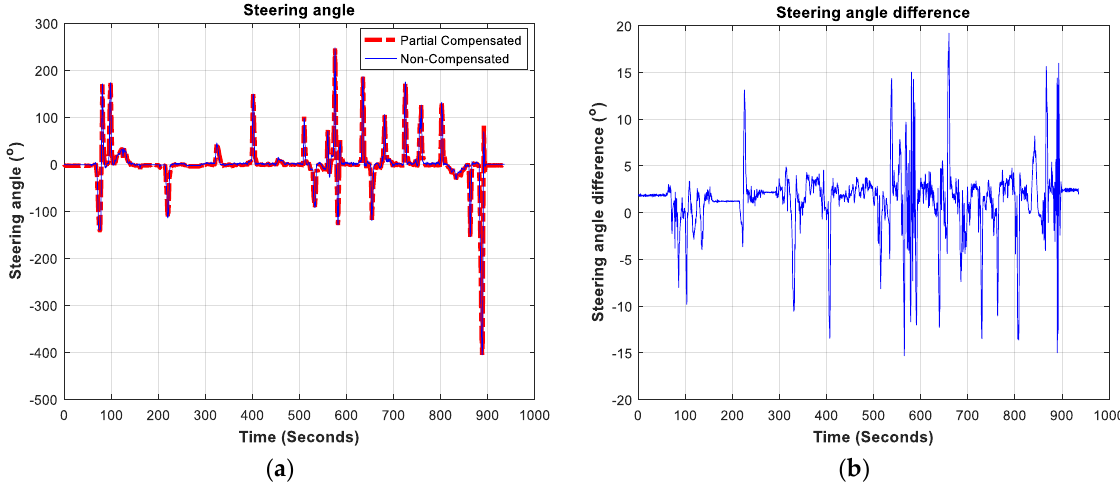
Figure 9. ( a ) Partially- and non-compensated steering angle estimation method; ( b ) the steering angle difference between the partially and non-compensated steering angle estimation methods.